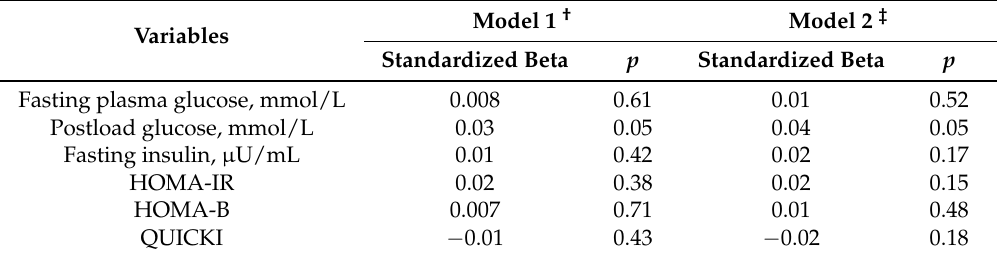
Table 2. Beta coefficients of the association between the dietary inflammatory index (DII) and glucose-insulin homeostasis markers